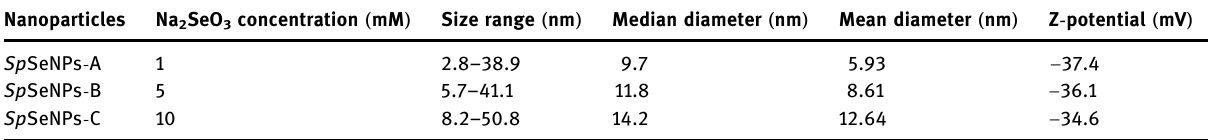
Table 1: Characteristic attributes of the phycosynthesized Sp SeNPs using di ff erent concentrations from Na 2 SeO 3 Nanoparticles